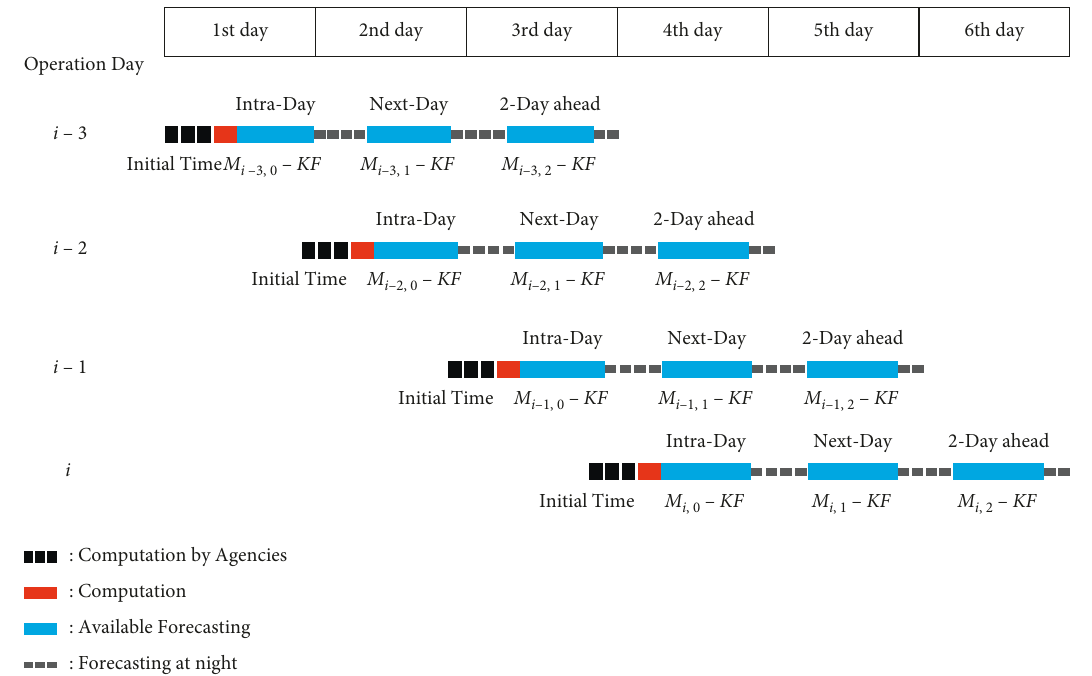
Figure 7: Cycle of operation for the solar GHI ensemble prediction based upon model WRF and method Kalman